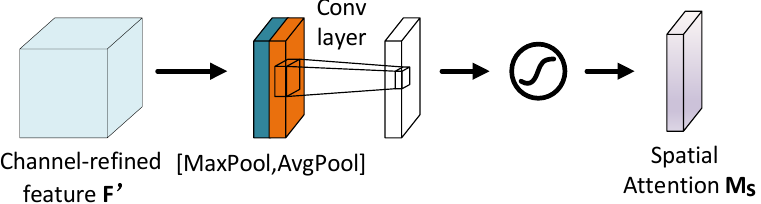
Figure 5. The spatial attention module of CBAM. Spatial attention map M s is generated by pooling operations on the feature map.